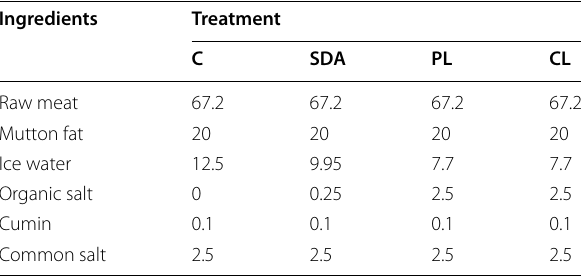
C, control; SDA, curry with 0.25% sodium diacetate; PL, curry with 2.5% potassium lactate; CL, curry with 2.5% calcium lactate